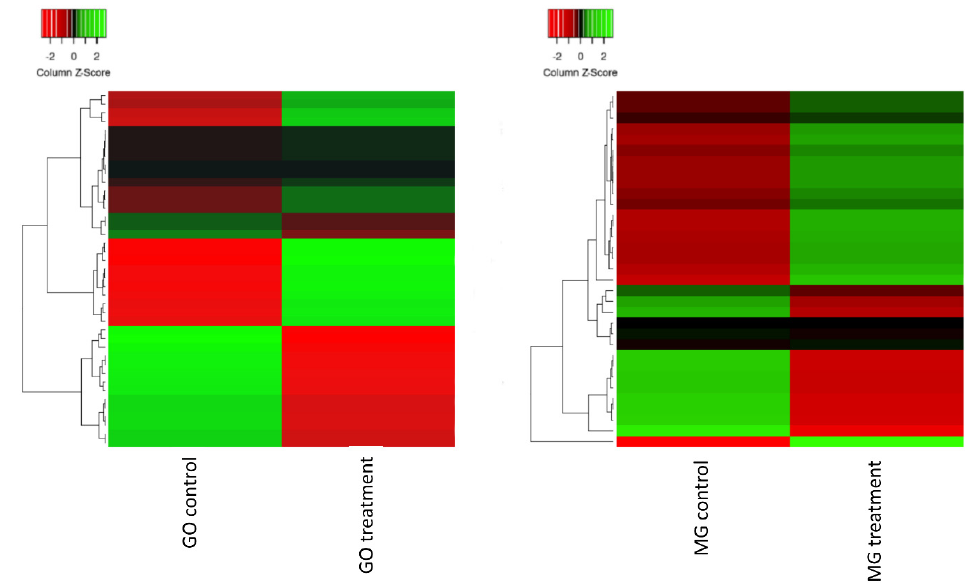
Figure 4. Heatmap of selected genes possibly involved with the aging/longevity process exhibited in Table 3. Red color indicates highly expressed genes (up regulated), and green represents the down-regulated genes. The green to red color transition reflects the values of an FPKM normalized log2-transformed counts. Gene Ontology enrichment analysis revealed that most genes are mainly related with the control of gene expression in the GOIAS control vs. GOIAS aged-seeds comparison